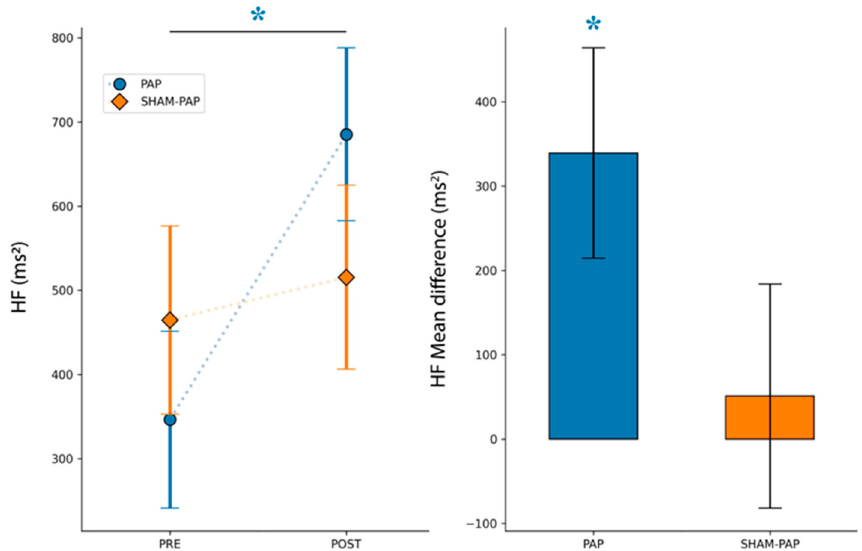
Figure 4. Frequency-domain parameter of HRV at rest, pre- and post-treatment. HF band. Data presented are mean ± standard errors of the mean (SEM). Asterisk marks a significant difference ( p < 0.05).